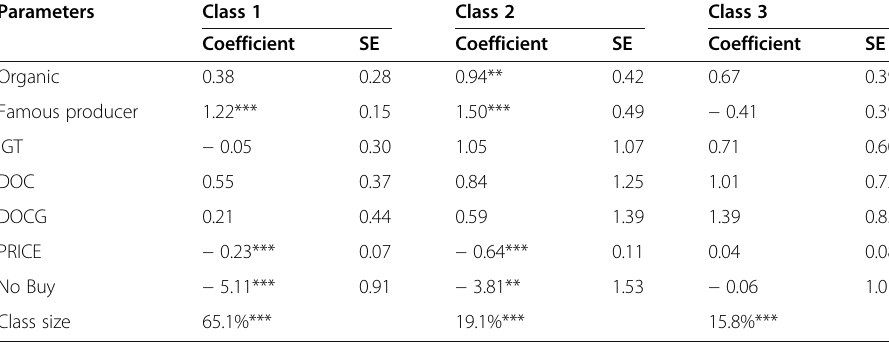
Table 4 LCM results with three classes